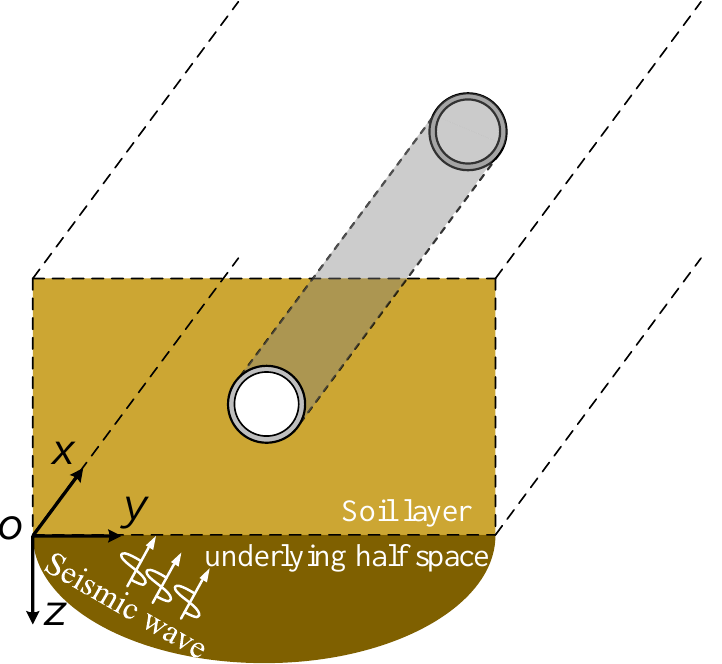
Figure 1. 2.5D soil–structure interaction model with oblique incidence of seismic wave.